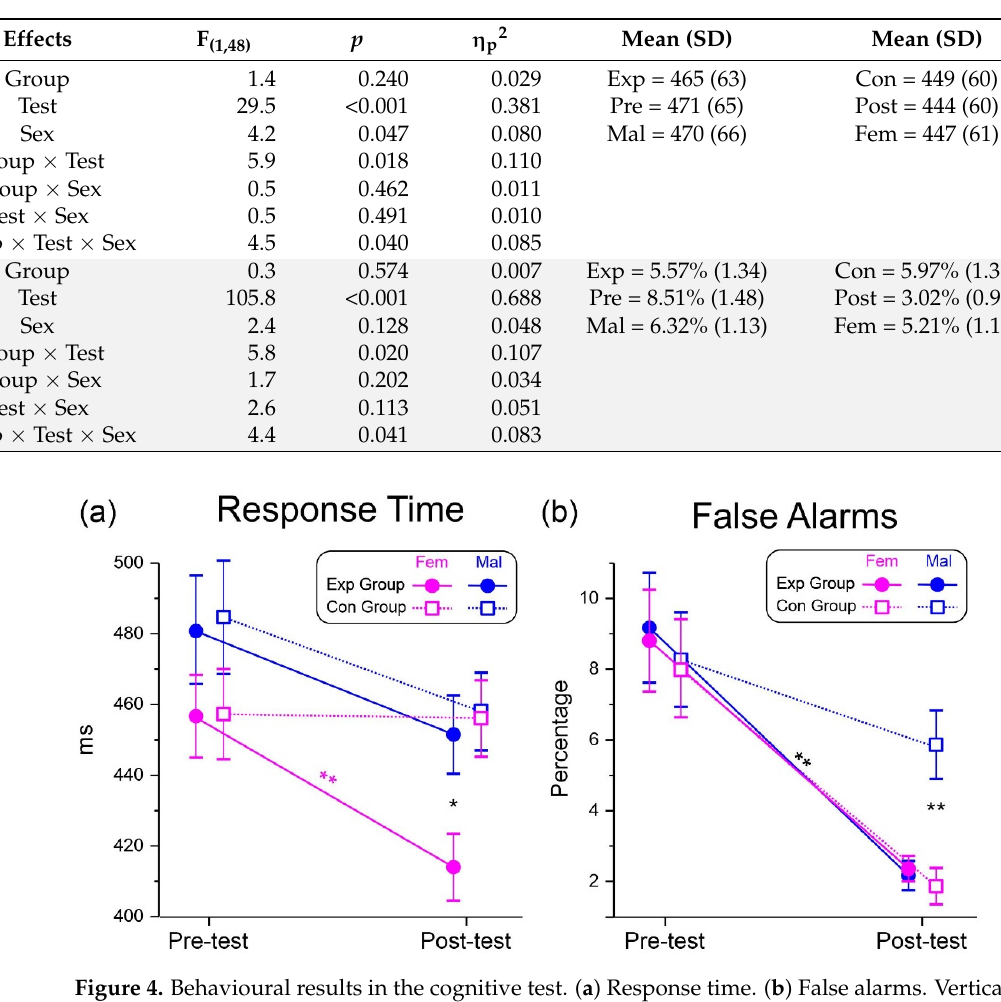
Table 2. Main effects and the interaction of the ANOVA in the behavioural data of the cognitive test. Response times (RT) are expressed in milliseconds and false alarms (FA) as percentages. See Table 1 for other information.